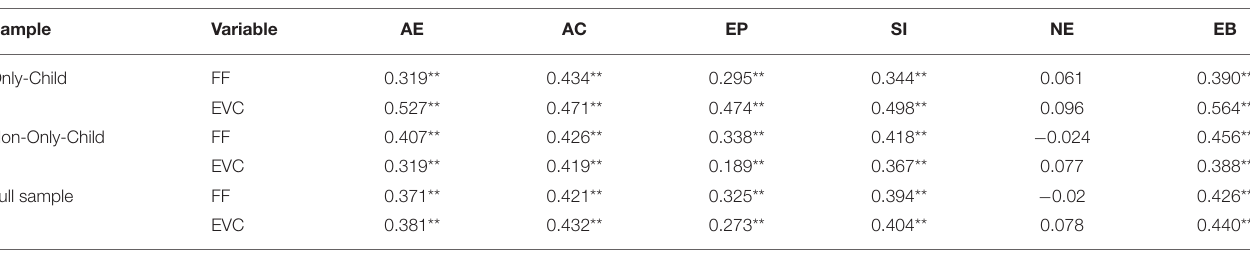
TABLE 2 | Pearson correlation analysis of FF, exercise value cognition, and exercise behavior. Sample